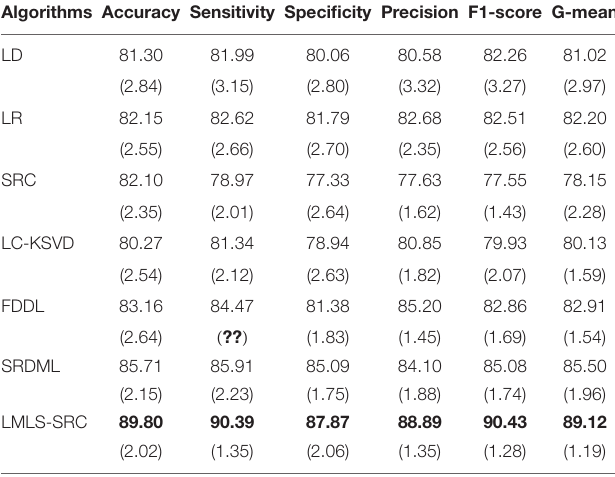
TABLE 5 | The comparative training results (with standard deviation) in four-class classification